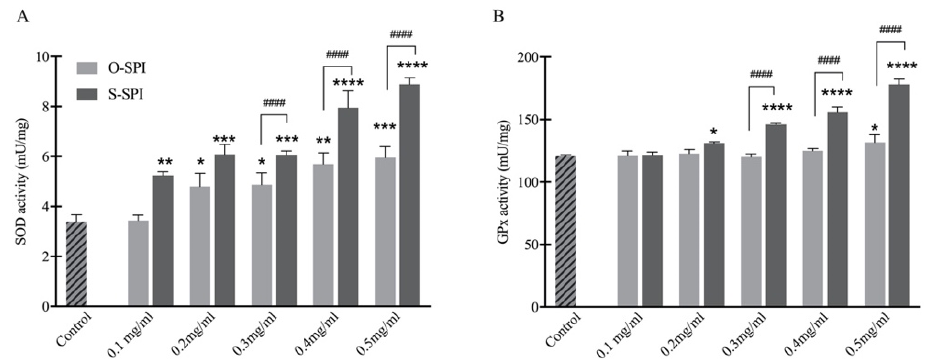
Figure 3. In vitro effects of S-SPI on antioxidant enzymatic activity of SOD ( A ) and GPx ( B ). Caco-2 cells were pretreated with different concentrations of SPI (0.1–0.5 mg/mL) for 12 h min and then treated with 400 μ M H 2 O 2 for 6 h. Values are expressed as mean ± SEM (n = 3). Significant differences between control group and other group are indicated by * p < 0.05, ** p < 0.01, *** p < 0.001, **** p < 0.0001. Differences between O-SPI and C-SPI under same concentration are indicated by #### p < 0.0001. Differences are analyzed with a two-way analysis of variance (ANOVA) followed by a Tukey test.